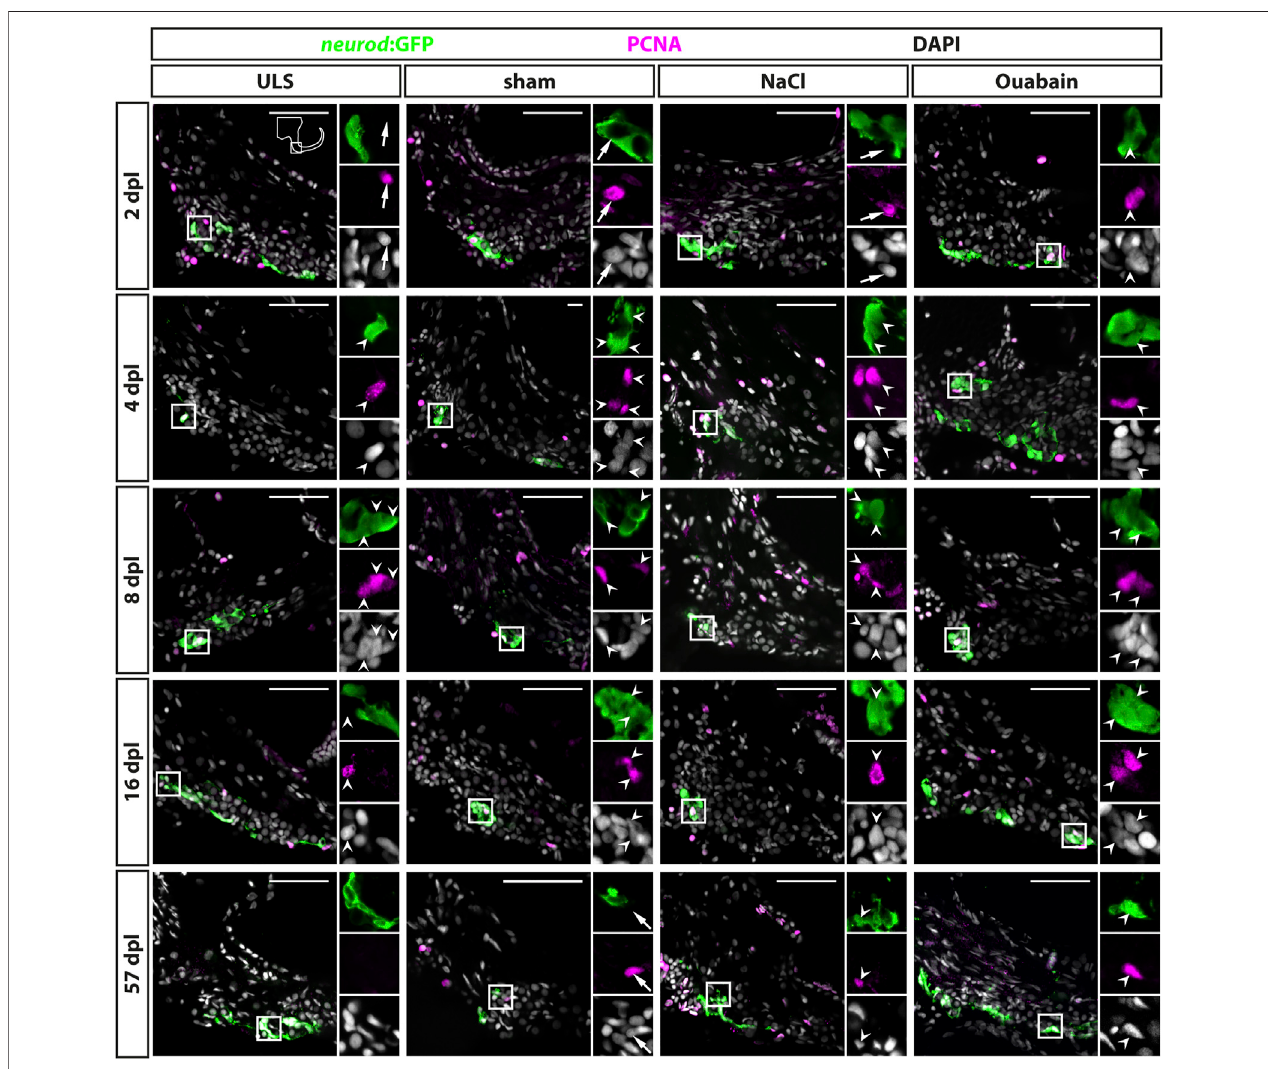
FIGURE 4 | Reactive proliferation of neurod :GFP-positive progenitors in the adult zebra fi sh SAG upon lesion. Immunohistochemistry against the proliferation markerproliferatingcell nuclear antigen (PCNA) and GFPin theSAGof neurod :GFP transgenic animals.Shown are representative images ofthe neurogenic niche ofthe SAG following sham treatment, or NaCl or ouabain injection as well as the unlesioned side (ULS) of either sham-treated, or NaCl- or ouabain-injected animals at 2, 4, 8, 16, and 57 days post lesion (dpl). Boxesshow close-ups to visualize costaining. Proliferating but marker-negativecells close to neurod: GFP-positive cells (arrows) were found frequently in unlesioned sides, for example, at 2 dpl and in sham-treated SAGs at 57 dpl. However, proliferating neurod: GFP/PCNA double-positive cells (arrowheads) were also present from 2 dpl onward in ouabain-injected animals (right column) and frequently from 4 dpl onward in sham-treated and NaCl-injected animals(medial columns).Proliferating neurod: GFP/PCNA double-positive cells continued to bepresentat 8and 16 dpl before returning tohomeostatic levels at 57 dpl when the majority of sham-treated, or NaCl- or ouabain-injected animals did not show proliferating neuronal progenitors in the lesioned SAG. In SAGs of unlesioned sides, PCNA /neurod :GFP double-positive cells are found occasionally, in particular, in the unlesioned sides of ouabain-injected fi sh at 8 dpl. Scale bar: 50 µm.